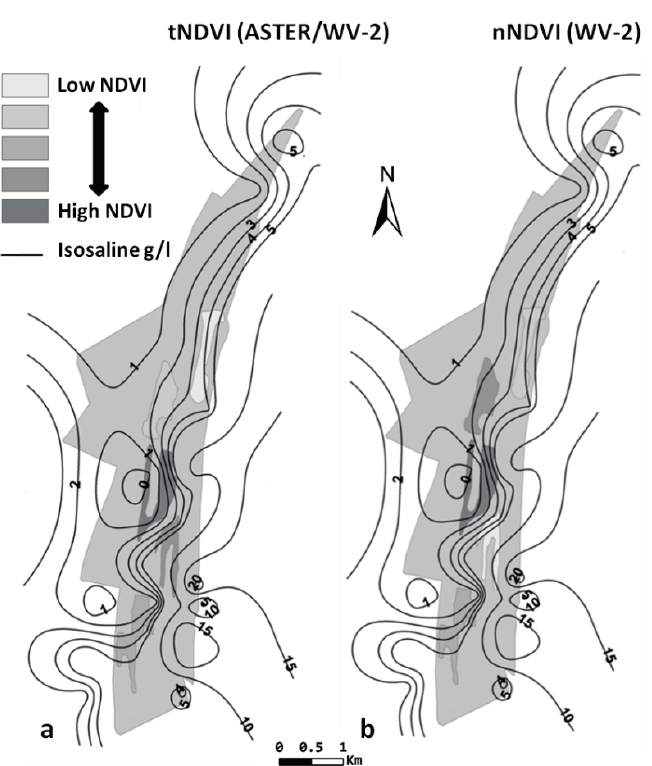
Fig. 3 Salinity maps for May 2011 and the ranking of the AOIs based on the average NDVI calculated with the traditional bands (a) and using the new RE band (b) Table 1 Comparison between average tNDVI and nNDVI for each AOI and the corresponding average salinity and average pine tree density. AOI Pine density N°/ha tNDVI (Aster/WV-2) nNDVI (WV-2) Salinity